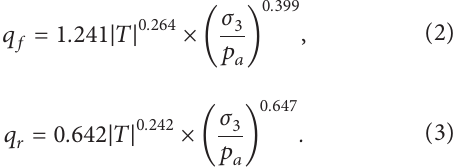
Figure 3: Triaxial equipment and tested samples: (a) the triaxial test device; (b) the CT scanner; (c) the specimen before and after testing. Table 2: Experimental schemes of the triaxial